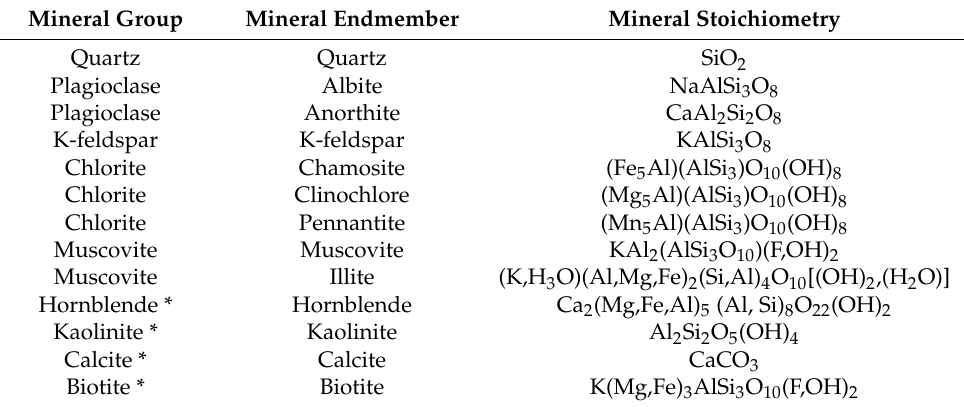
Table 1. List of minerals used in Analysis to Mineralogy (A2M), the mineral group, its endmembers (where relevant), and their